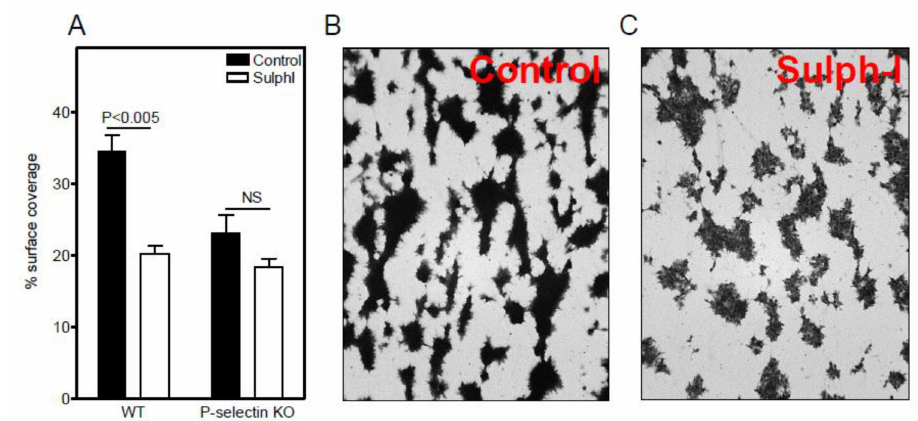
Figure 1. Contribution of sulfatides to P-selectin-dependent aggregate formation of mouse platelets under flow. ( A ) Whole blood from wildtype (WT) and P-selectin knockout (KO) mice was perfused over equine collagen-coated coverslips in a single-passage perfusion chamber in the absence (closed bars) or presence of SulphI antibody (10 µ g / mL; open bars) at a shear rate of 150 s − 1 . Coverslips were stained with May-Grünwald-Giemsa and evaluated by light microscopy for % surface coverage. Data are means ± S.E.M. of single perfusion performed in triplicate and are representative for three perfusions. ( B , C ) Microscopic high power views showing that WT aggregates were more densely packed in the absence ( B ) than in the presence of SulphI antibody ( C ). NS: not